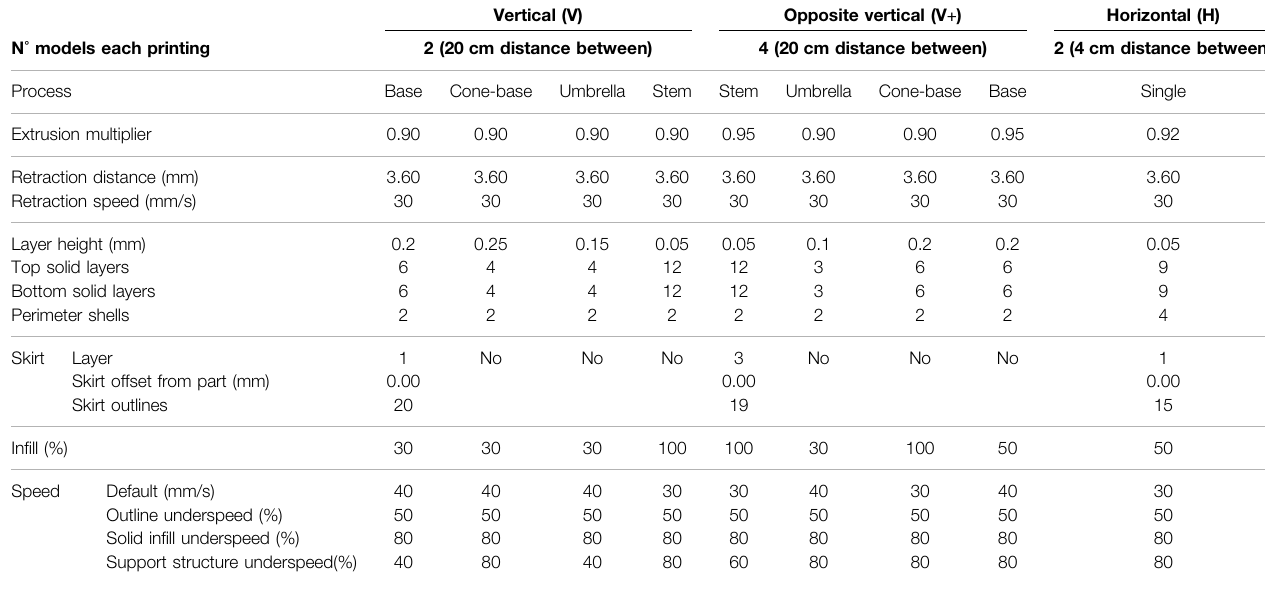
TABLE 1 | Printing parameters for different printing orientation of the PEEK-plugs. Vertical (V) Opposite vertical (V + ) Horizontal